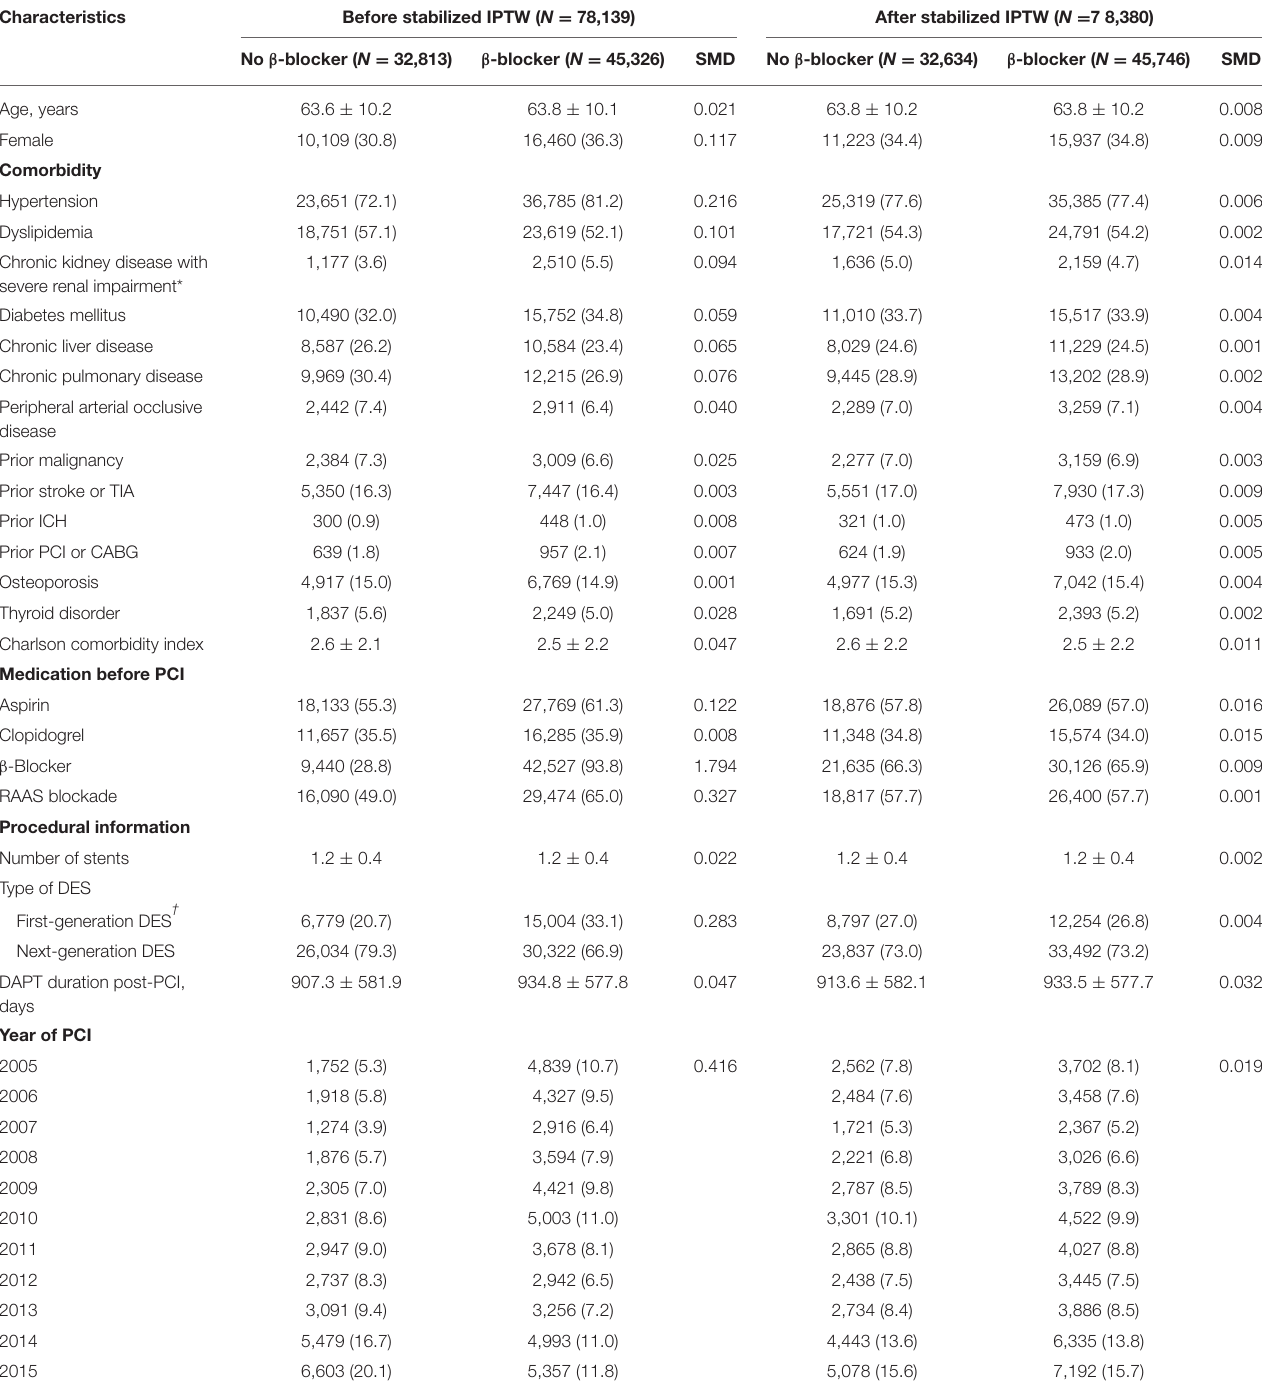
TABLE 1 | Baseline characteristics and medications in all patients.